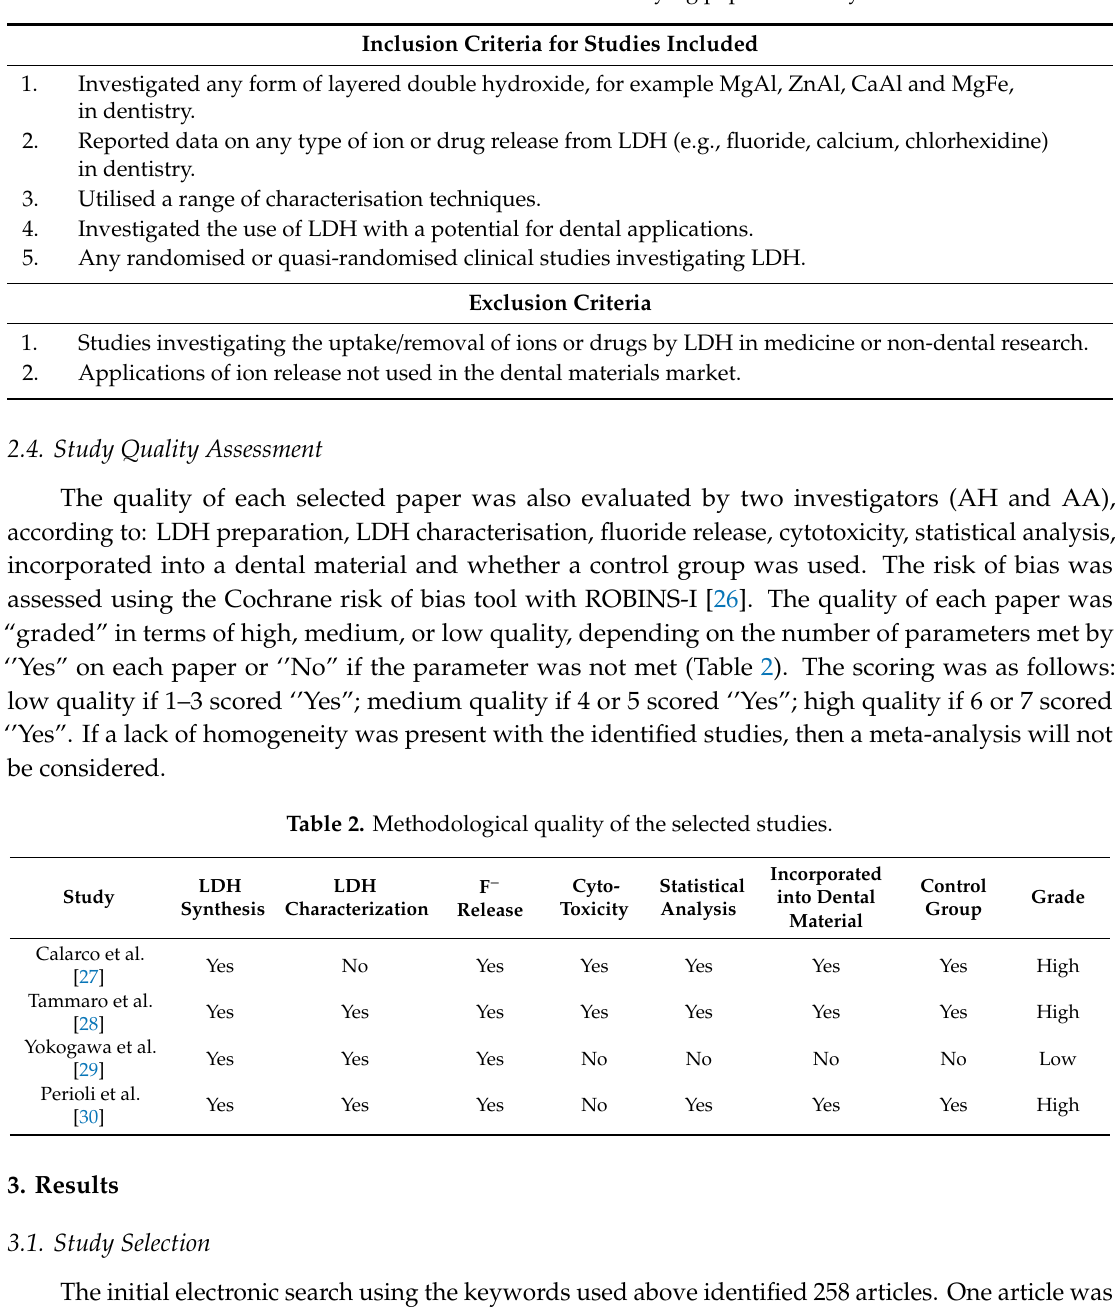
Table 1. Inclusion and exclusion criteria used for identifying papers in the systematic review.